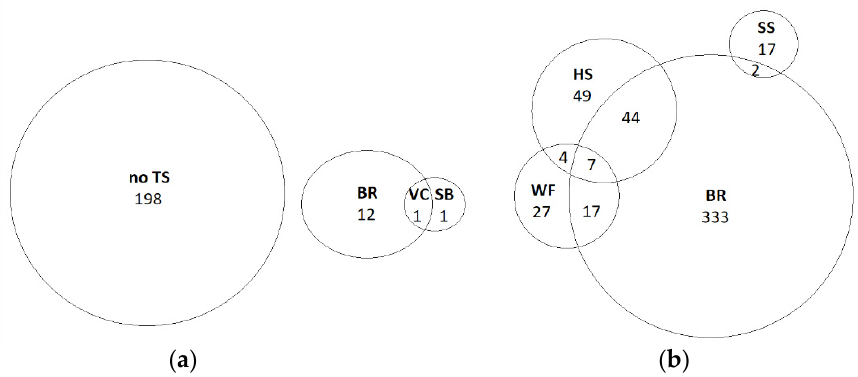
Figure 2. Venn diagram of animal-based indicators of consciousness assessed in broilers ( a ) before bleeding in waterbath stunned broilers and ( b ) during bleeding. Indicators of consciousness were: no TS: absence of tonic seizure; BR: presence of breathing; SB: presence of spontaneous blinking; VC: presence of vocalization; WF: presence of wing flapping; HS: presence of head shaking; SS: presence of spontaneous swallowing. Numbers specify the total number of broilers showing each indicator or combinations of indicators from a total of 2608 broilers assessed before bleeding and 3105 during bleeding.